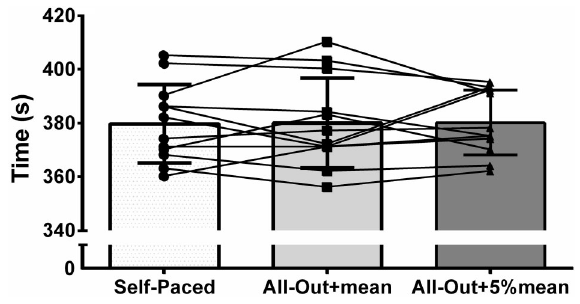
Figure 2. Overall performance during a 4-km cycling time trial adopting a self-paced strategy, an all-out start strategy for the fi rst 10 s, with further maintenance at mean baseline power for the remaining fi rst km and self-paced thereafter, and an all-out start strategy for the fi rst 10 s, followed by a power 5% above the baseline for the remaining fi rst km and self-paced thereafter. Data are reported as means ± SD and lines are individual data. . Table 1. Peak oxygen uptake ( VO 2 peak), ratings of perceived effort (RPEpeak), and heart rate (HRpeak) in the maximal incremental exercise test and 4-km cycling time trial adopting different pacing